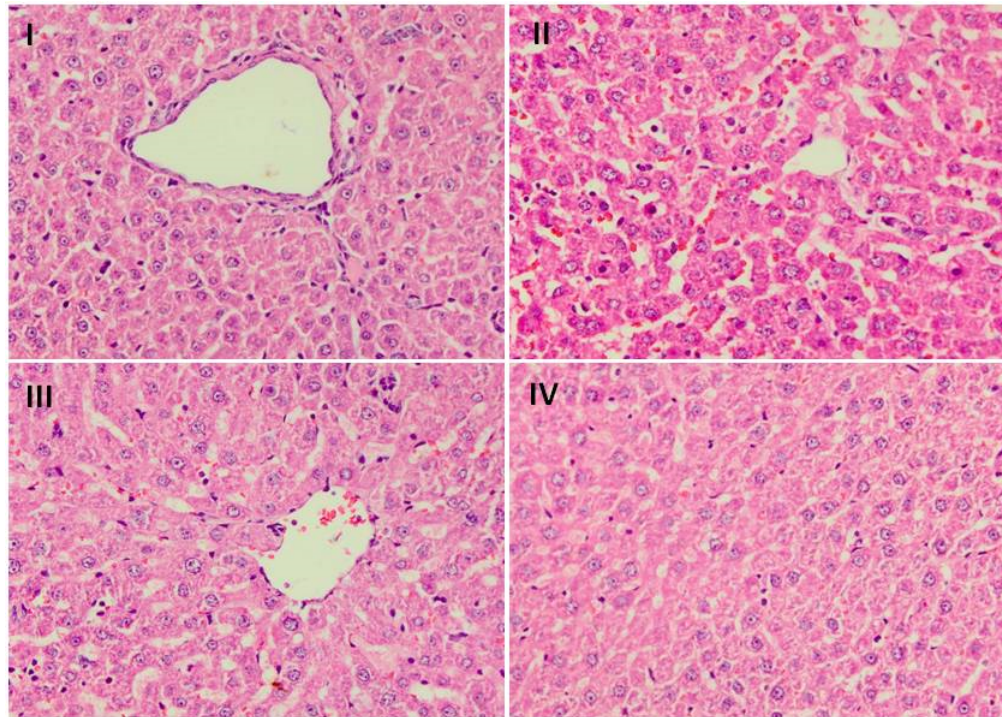
Figure 4. Effect of naringenin treatment on Dox-induced pathological changes in liver. Photomicrographs of